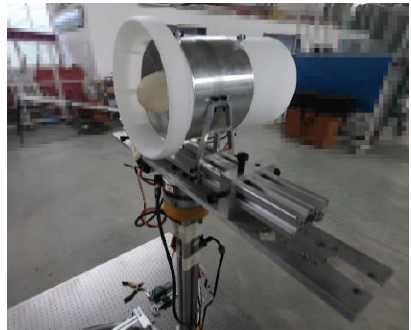
Figure 3. Experimental site and connection mode of the 150 ducted fan.